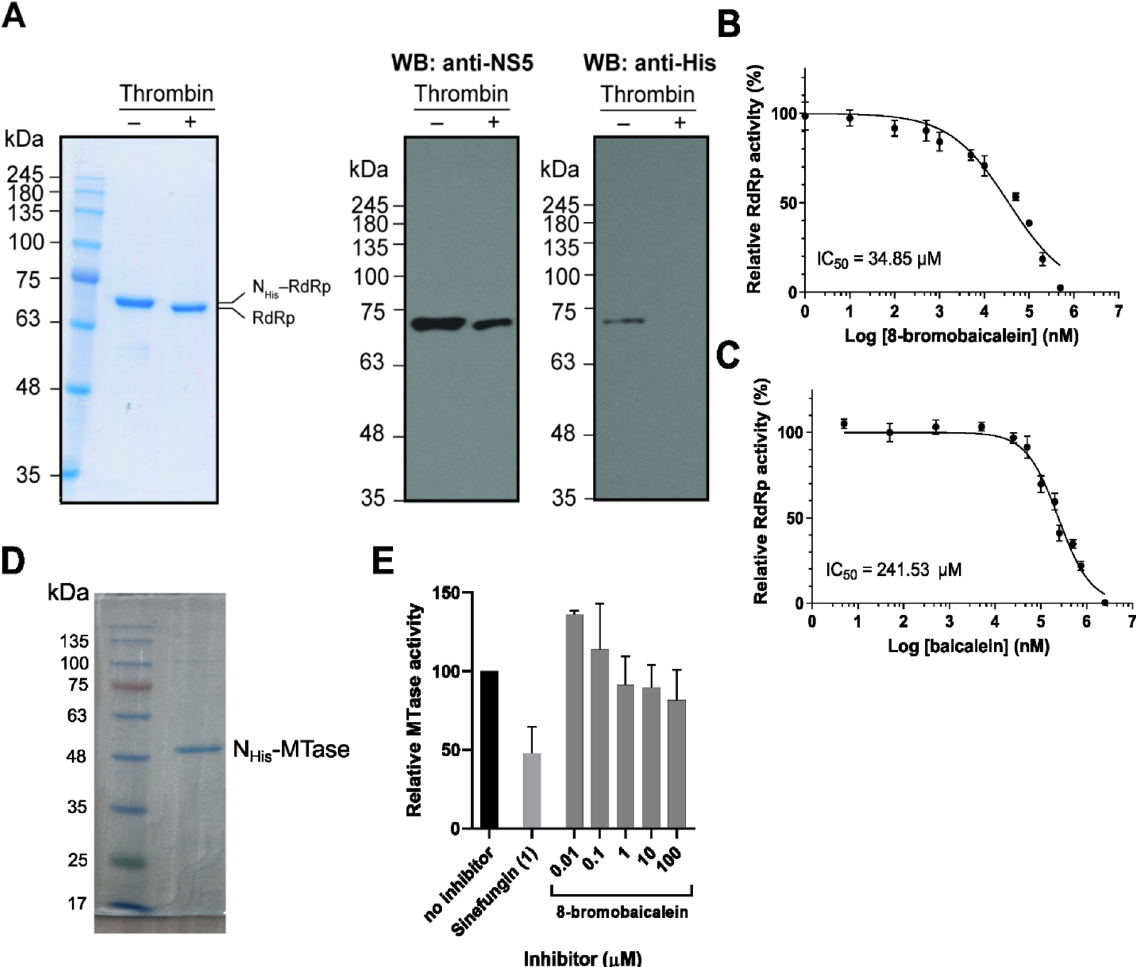
Figure 4. ( A ) Coomassie staining (upper panel) and western blotting (lower panel) of purified RdRps upon thrombin treatment. ( B ) IC 50 of 8-bromobaicalein and ( C ) baicalein was determined by the RdRp assay. ( D ) Coomassie staining of purified MTase and ( E ) its activities in the presence of